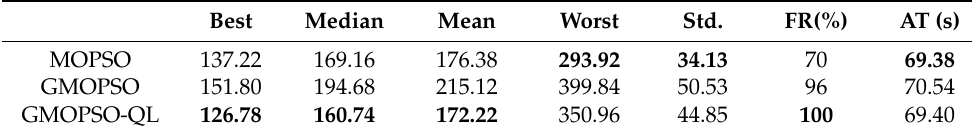
Table 1. Comparison results of various algorithms in Case 1.